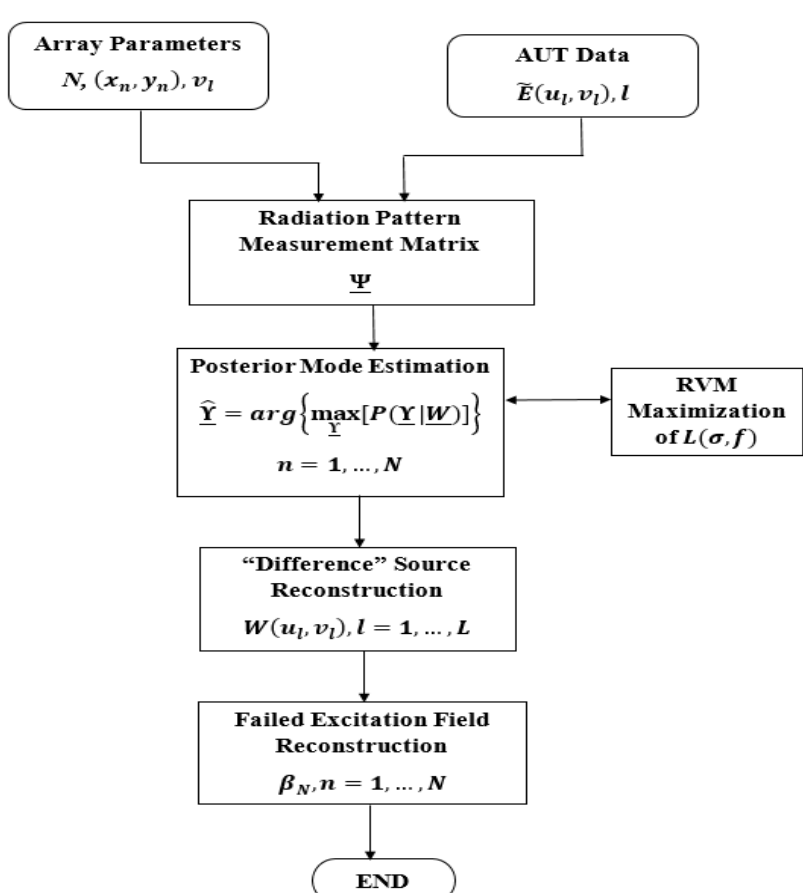
Figure 3. Flowchart of the proposed Bayesian compressive sensing (BCS) procedure.